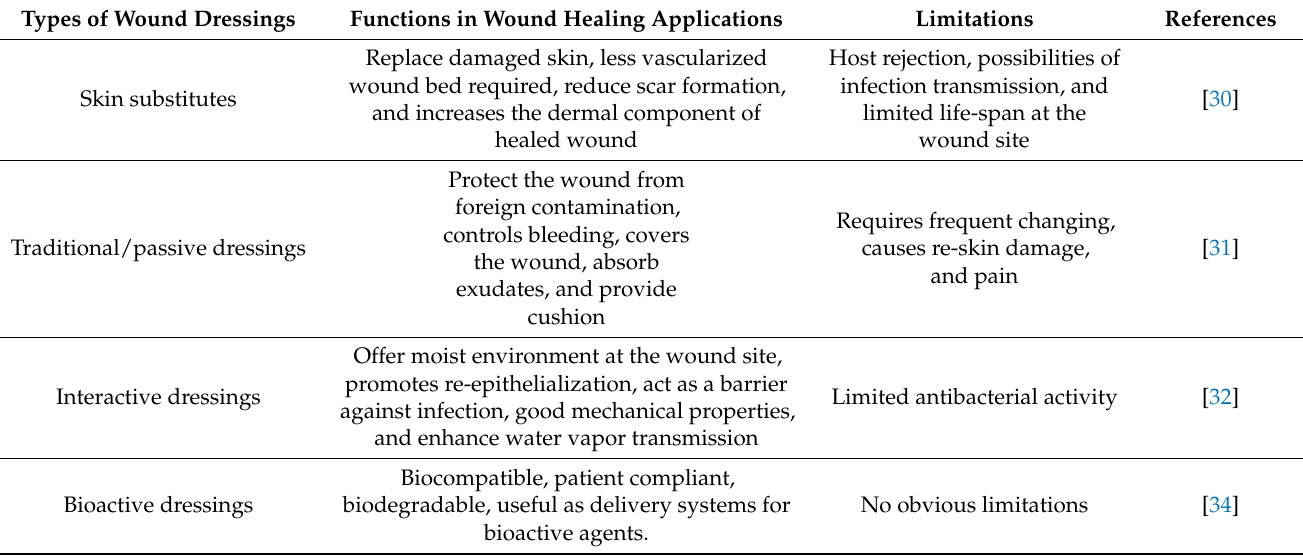
Table 1. Classifications of wound dressings with their functions and